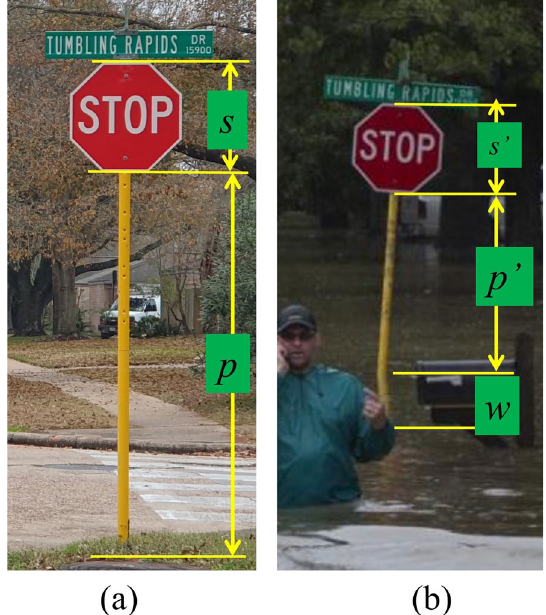
Fig. 1 Flood depth estimation in a paired a pre-flood photo and b post-flood photo (base photo in ( b ) is courtesy of Erich Schlegel/ Getty